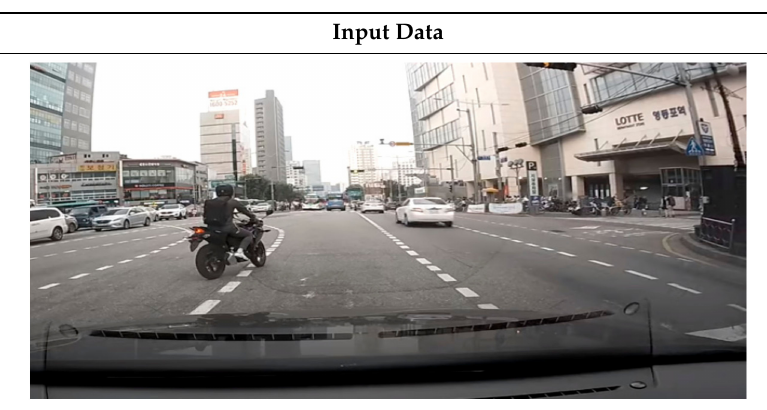
Table 6. Scenario Generation Result